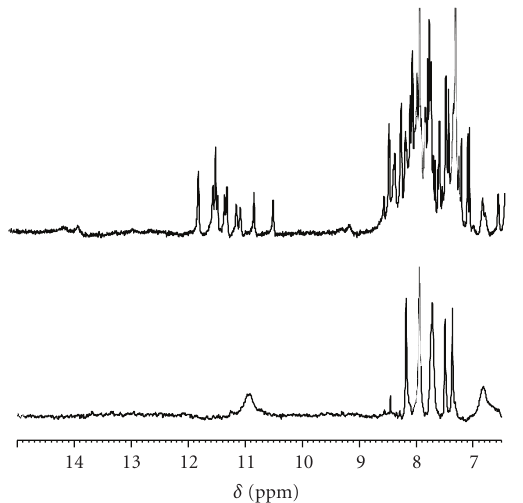
Figure 2: NOESY spectra of d < pGGGTTAGGGTTA > in D 2 O (200ms mixing time) at 600 μ M oligonucleotide concentration (same bu ff er conditions as in Figure 1). The eight thymine signals are indicated together with some informative sequential NOE